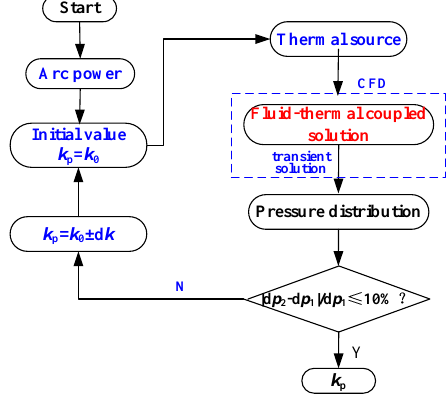
Figure 4. Flowchart of the k p - determination method.